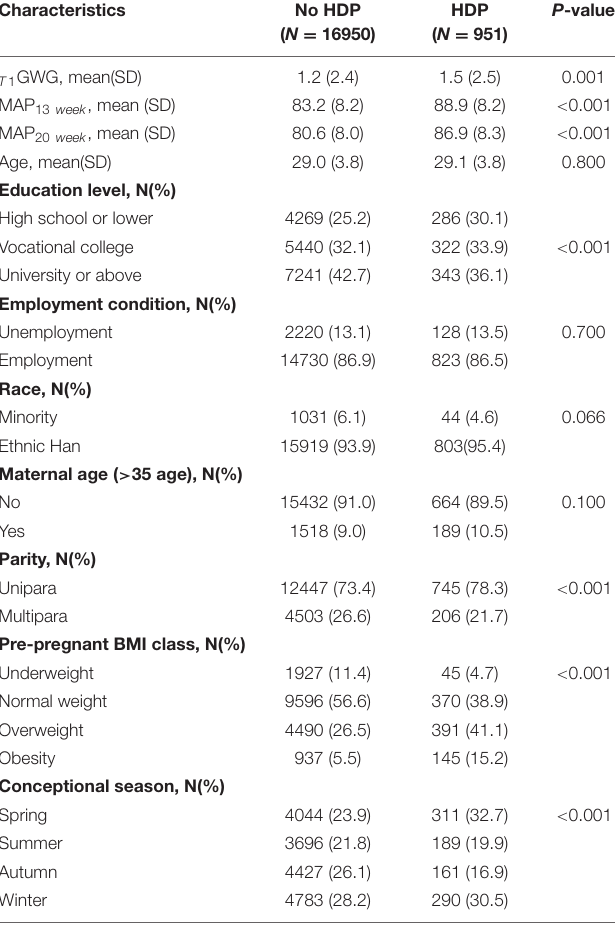
TABLE 1 | Maternal socio-demographical and first-trimester weight gain characteristics.